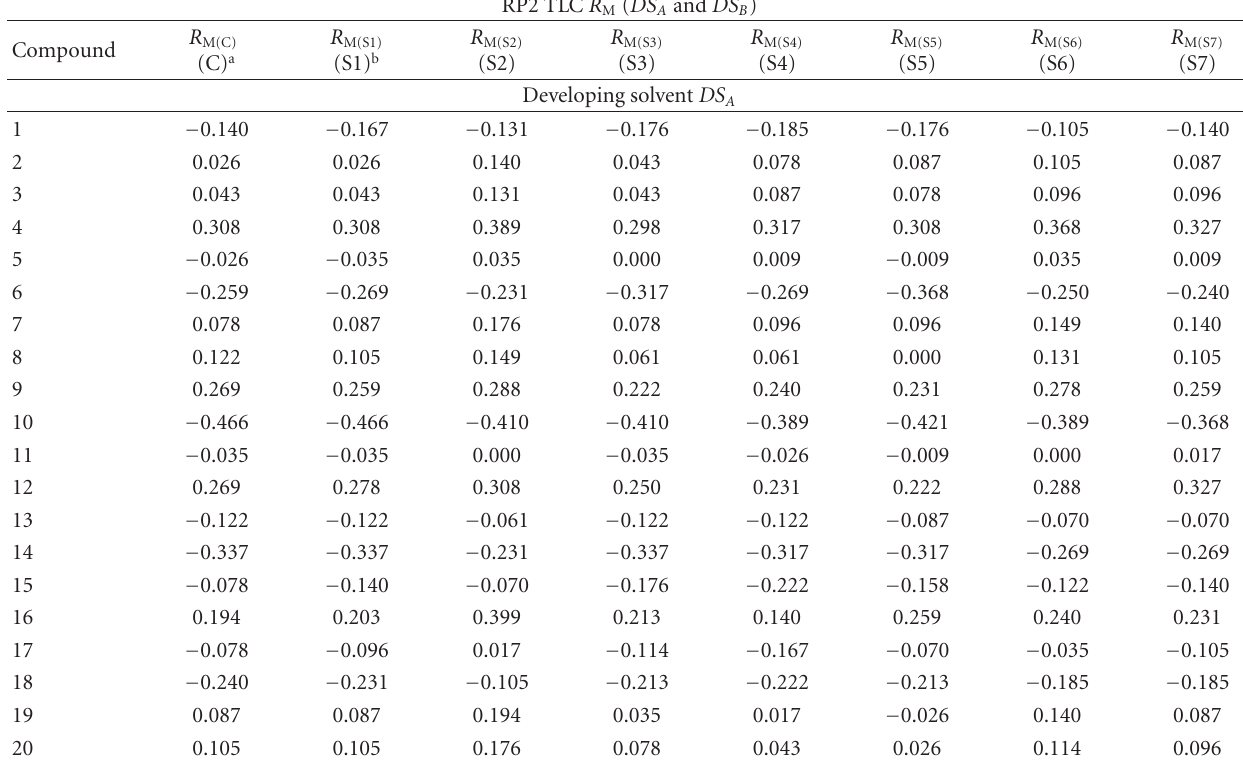
Table 2: R M values for the experiment with RP2 TLC